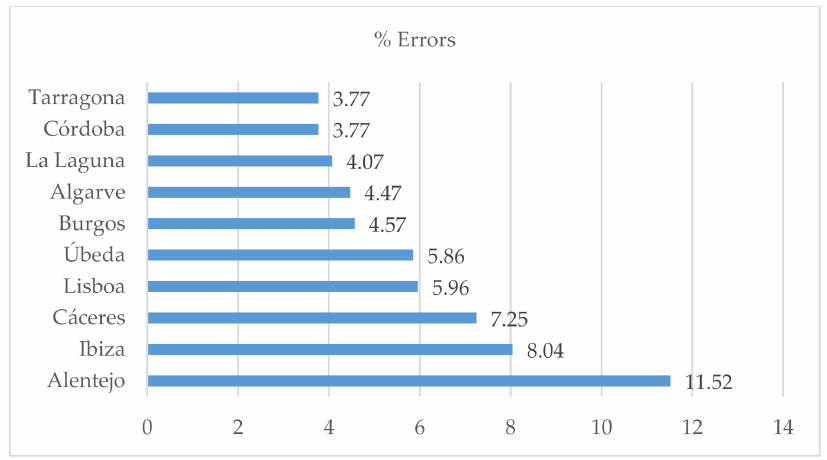
Figure 5. Percentage of errors in the official tourism websites of the Tur4all accessible destinations analyzed in Spain and Portugal. Source: own elaboration from Wave [54].